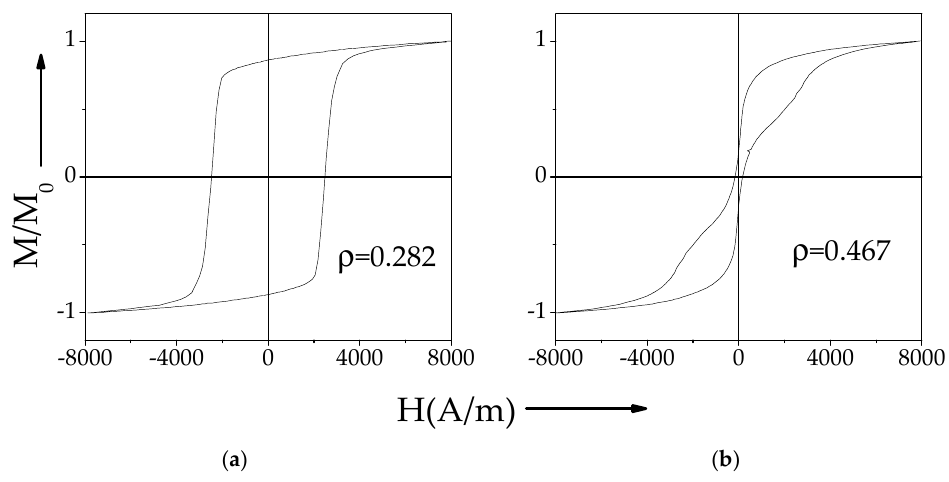
Figure 16. Hysteresis loops of Fe 71,8 Cu 1 Nb 3,1 Si 15 B 9,1 microwires with ρ = 0.282 ( a ) and ρ = 0.467 ( b ) annealed at 700 ◦ C. Adapted from